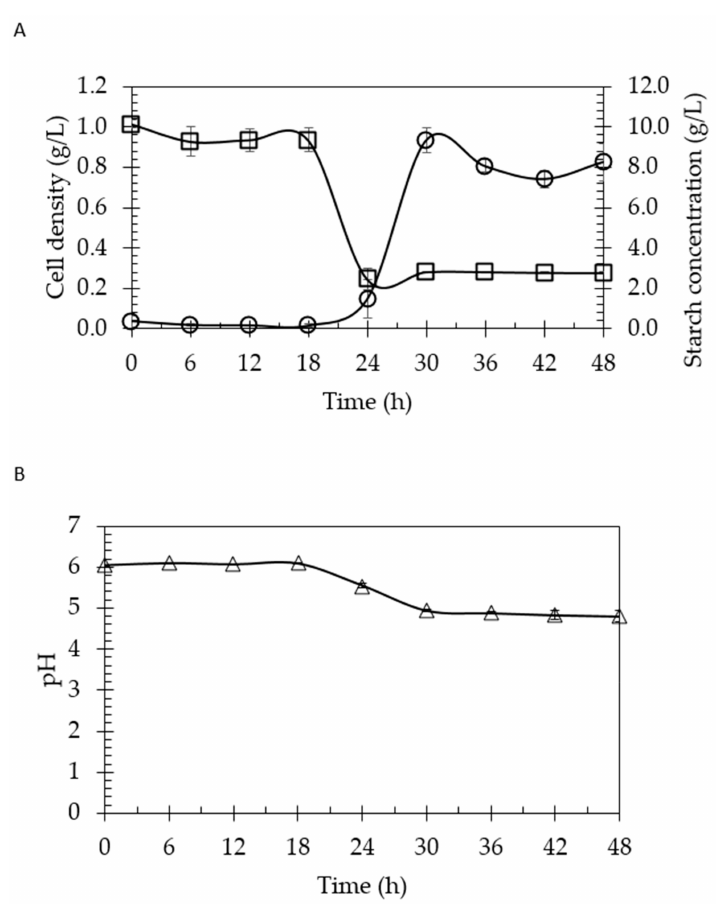
Figure 1. Profiling of Clostridium beijerinckii SR1 in 10 g / L of commercial starch. ( A ) The cell density ( and commercial starch consumption ( (cid:3) ) as a function of time. ( B ) pH